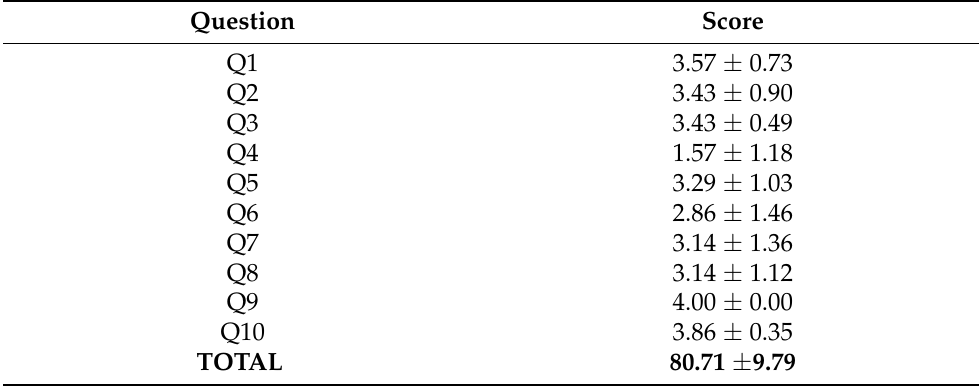
Table 3. Results of the Usability Scale questionnaire for each question. The score is expressed as mean ± standard